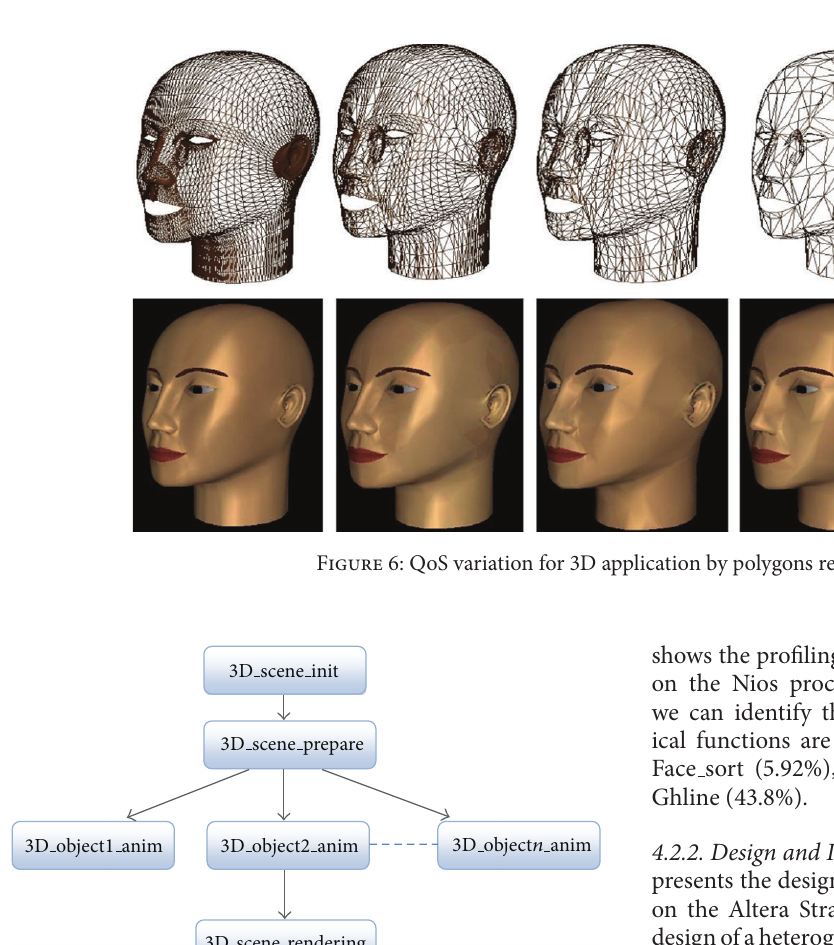
Figure 5: Task graph of the synthesis of 3D application.